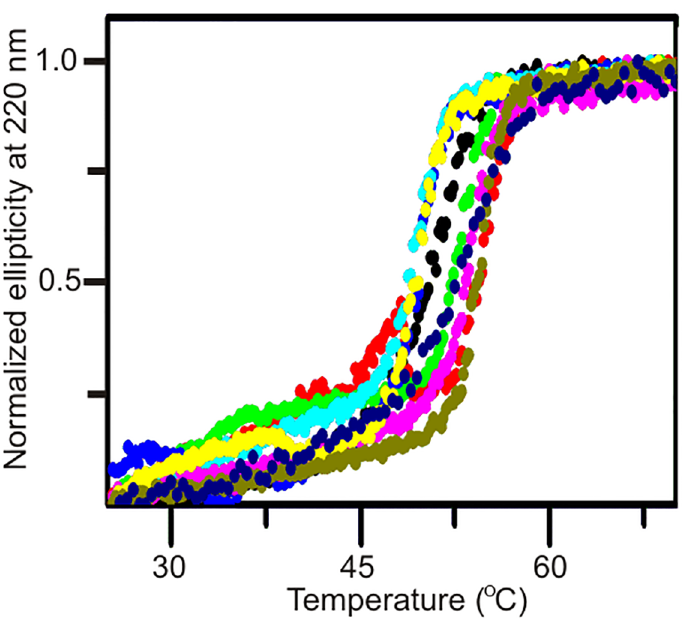
Fig 5. Thermal stability of Adk variants. The thermal stability of Adk1 yeast (black), Adk 1 : 00 (red), Adk 0 : 47 eco eco (green), Adk 0 : 20 (blue), Adk 0 : 12 (turquoise), Adk 0 : 06 (pink), Adk 0 : 04 (purple), Adk 0 : 007 (yellow) and Adk 0 : 0002 (olive) eco eco eco eco eco eco was quanti fi ed by observing normalized circular dichroism signals at a wavelength of 220 nm as a function of temperature. The data are displayed assuming a two-state unfolding model. Associated melting temperatures ( T M ) are displayed in Table